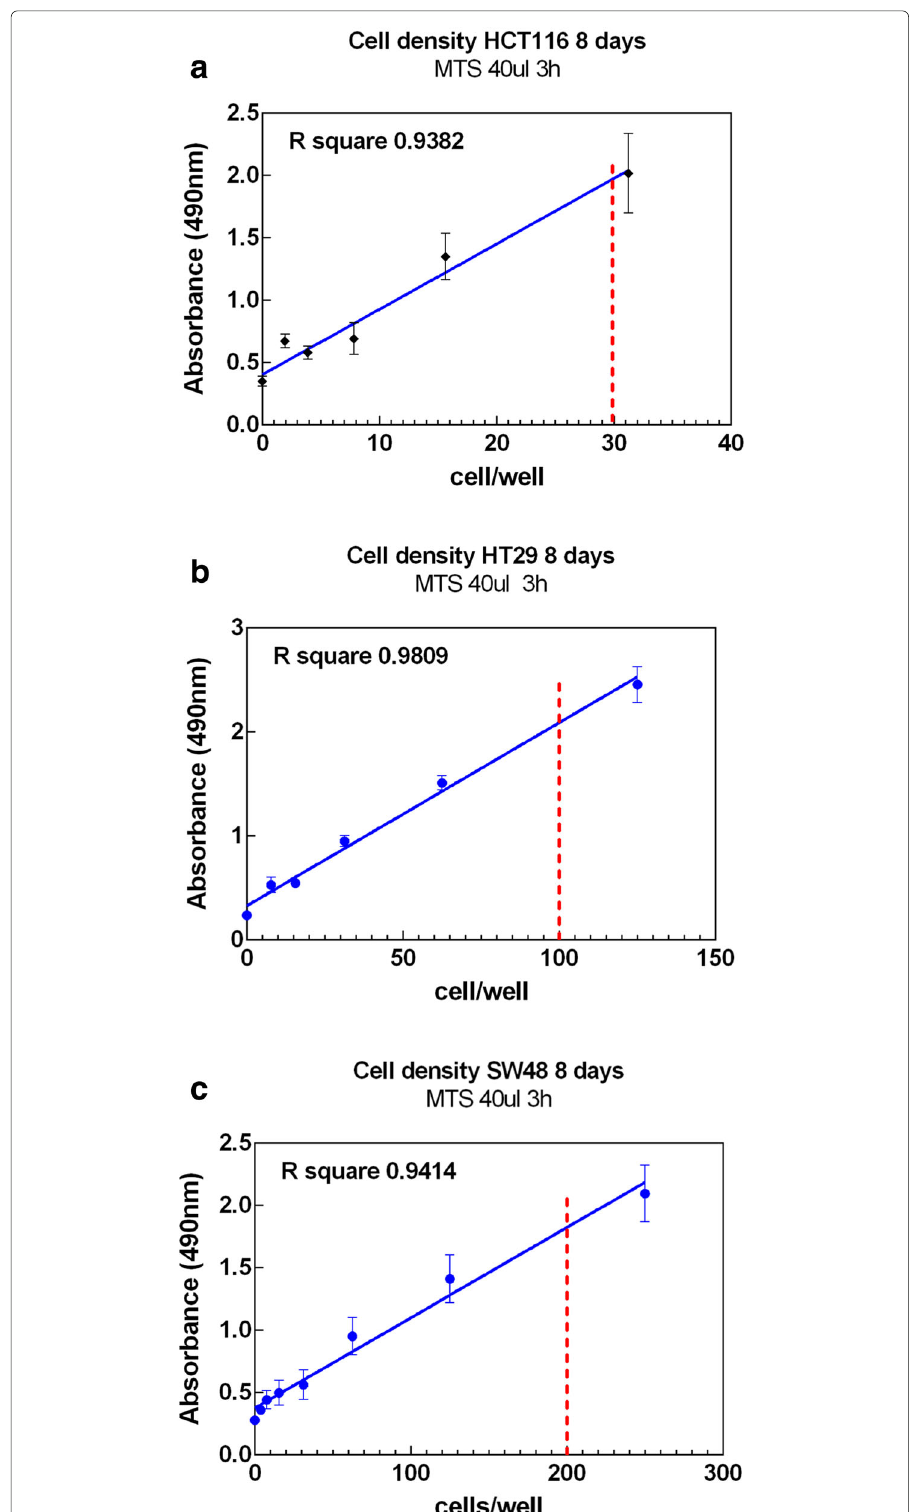
Fig. 4 Linear regression fit for the cell density of three cell lines. The red dashed line indicates the number of cells per well used to culture the